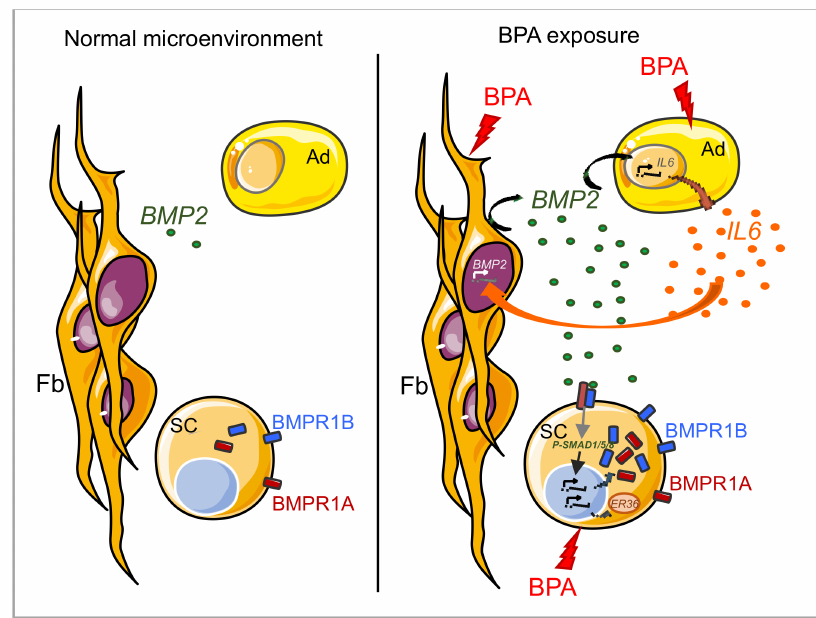
Figure 1. BPA-induced modifications of the mammary gland ecosystem. In the absence of BPA ( left panel ), BMP2 production by the breast microenvironment and BMP receptor expression by mammary epithelial cells sustains the homeostasis of the mammary gland. In the presence of BPA ( right panel ), BMP2 production by mammary fibroblasts is stimulated and in turn activates, in conjunction with BPA, IL6 production by adipocytes. IL6 can then further increase BMP2 production by fibroblasts. In parallel, BPA primes epithelial SCs cells to the increased BMP2 signaling by acting on BMP receptor expression and localization. This dysregulated BMP signaling and the inflammatory context provided by IL6 cooperate to favor mammary stem cell